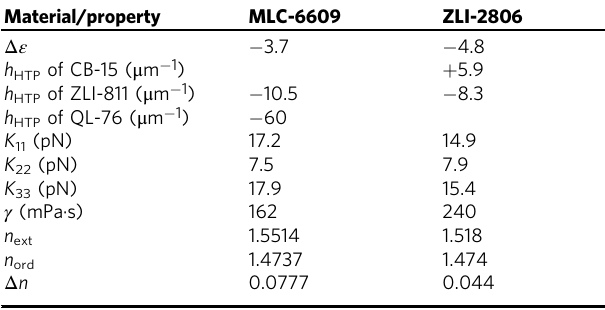
Table 1 Material properties of nematic hosts and chiral additives